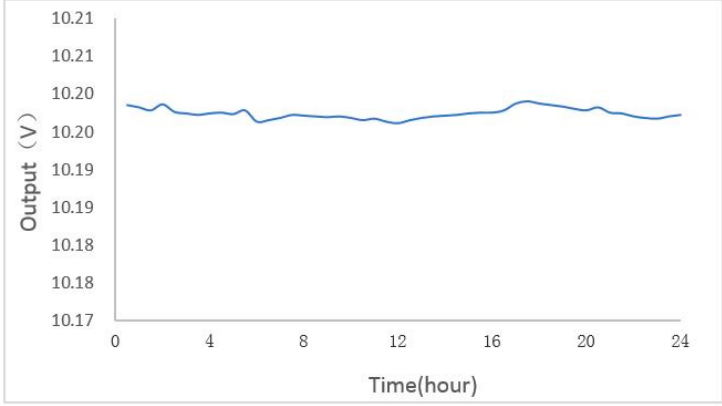
Figure 16. Zero stability of accelerometer in 24 h.